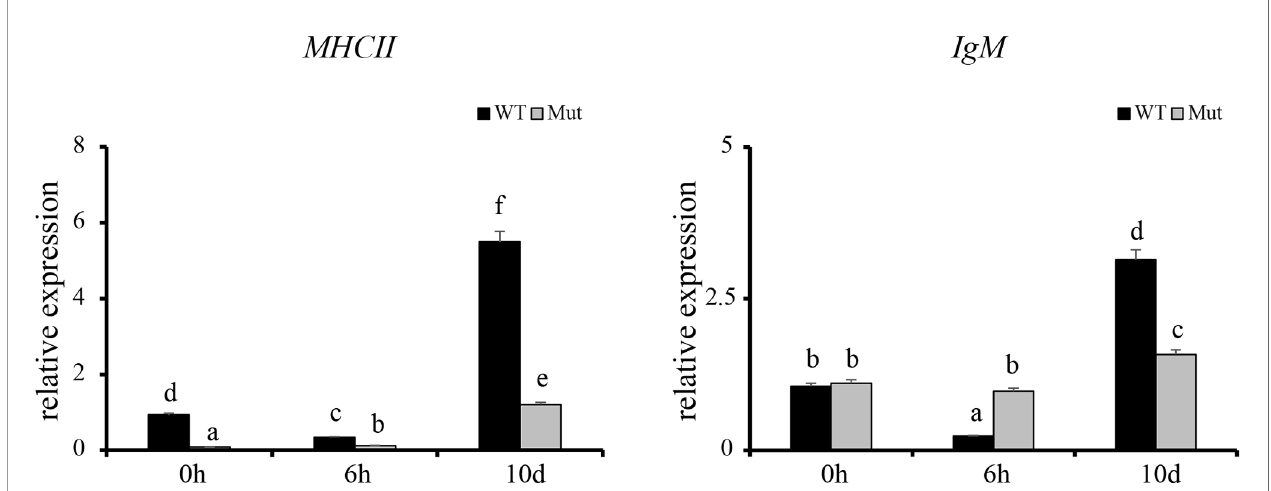
FIGURE 9 | Expression pro fi les of MHCII and IgM after vaccination in whole kidneys. WT animals and congenitally asplenic zebra fi sh sampled at 0 h were used as controls. The data were normalized to the expression level of WT-0h. The data are reported as the mean ± SEM. Different letters (a, b, c, etc.) indicate signi fi cant differences ( p <